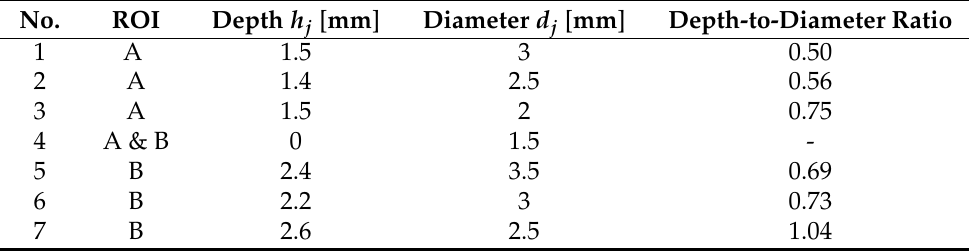
Table 1. Properties of each defect of the modified test specimen in the two ROIs A and B, compare with Figure